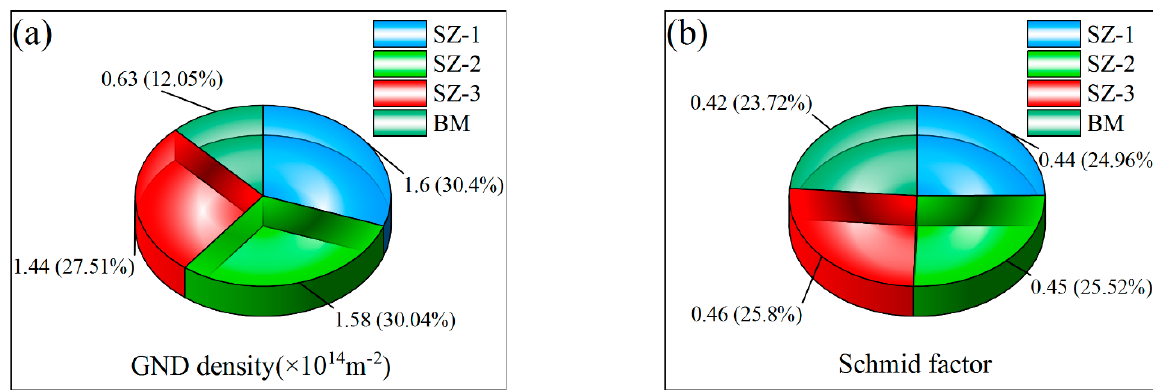
Figure 10. ( a ) GND density and ( b ) SF of SZ-1, SZ-2 and